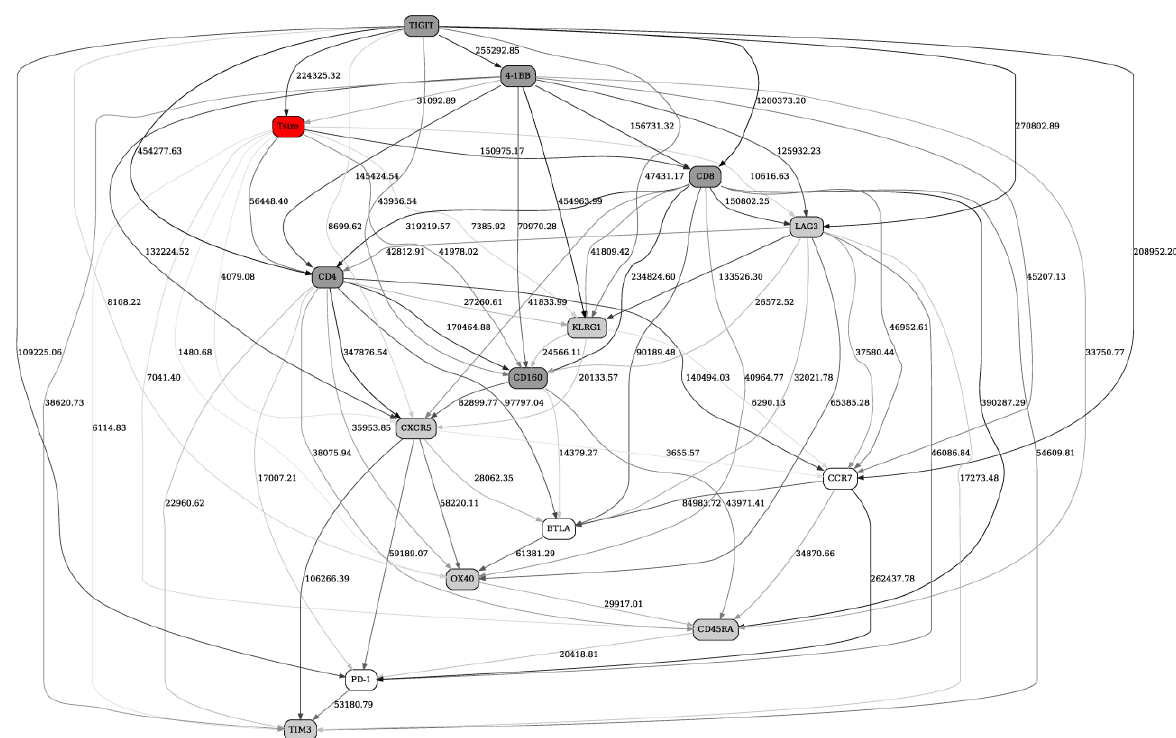
Figure 1. A full Bayesian network (BN) constructed from fluorescence-activated cell sorting (FACS) data (Checkpoint panel) from 13 patients preimmunotherapy treatment (day 1). The number next to the edge and edge thickness indicate dependency strength; arrows/edge directionalities distinguish parent/offspring relationships during the BN reconstruction, and do not necessarily imply causation flow (see Section 4 Materials and Methods: Bayesian networks modeling for details). “Tsize” node, highlighted in red, is the response status variable (4 responders, 9 nonresponders). Remaining nodes are immune marker variables. Response status node is directly strongly linked with five markers (TIGIT, CD4, CD8, CD160, 4-1BB, designated by dark grey nodes in the network) and, less strongly, with six other markers (TIM3, CD45RA, OX40, CXCR5, KLRG1, LAG3, light grey nodes in the network). See text for further details.